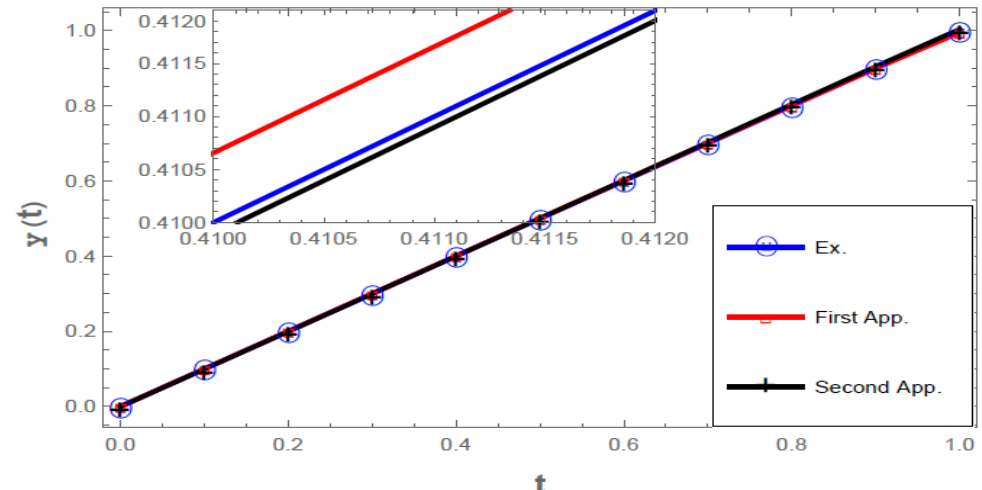
Figure 1. Exact solution, first approximation and second